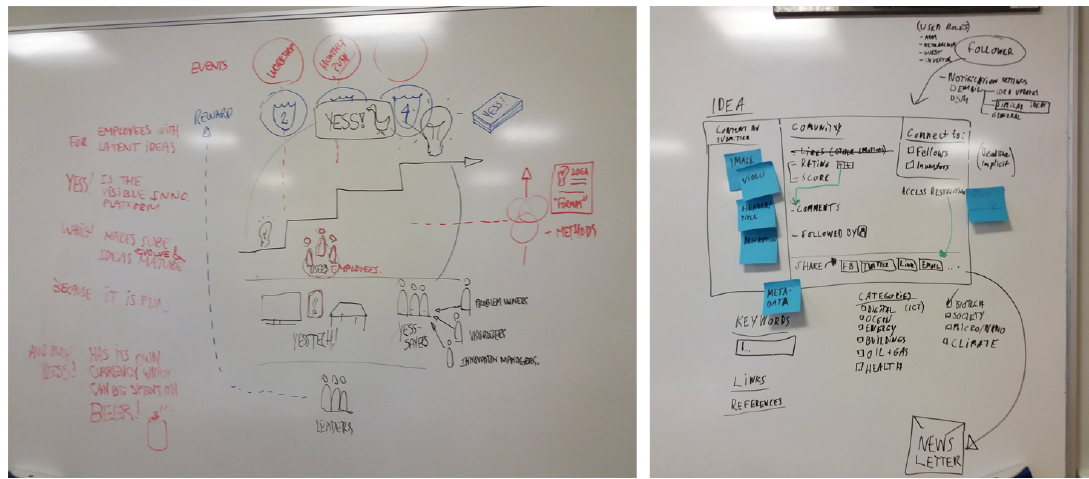
Figure 10. Implementation sketches from two